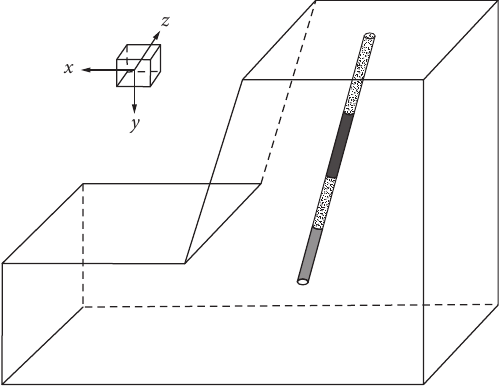
Figure 6: Illustration of the three-axis direction.